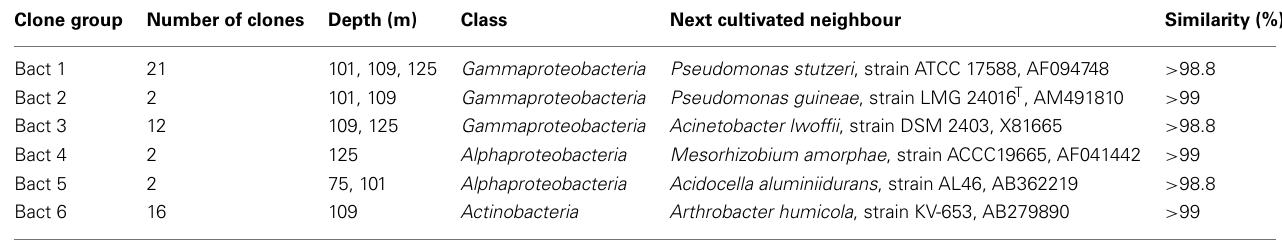
Table 2 | Summary of the phylogenetic analysis of bacterial 16S rRNA genes in terrestrial CBIS post-impact sediment. Clone group Number of clones Depth (m)